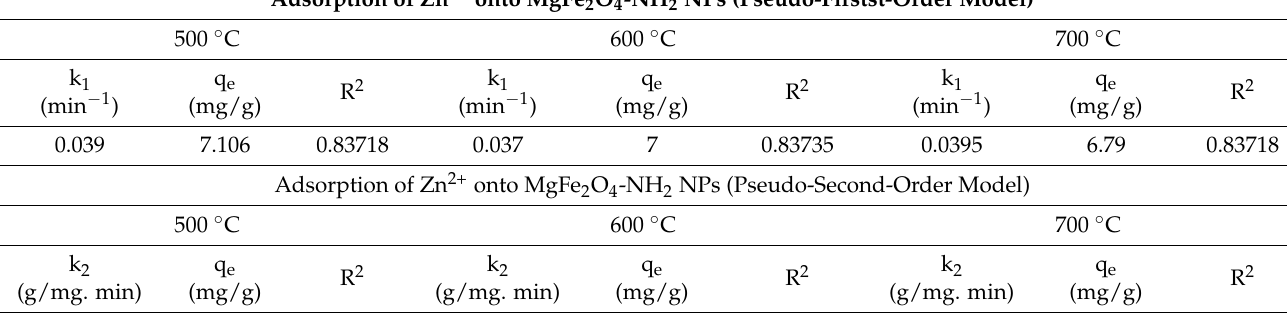
Table 3. Adsorption rate constant calculated from pseudo